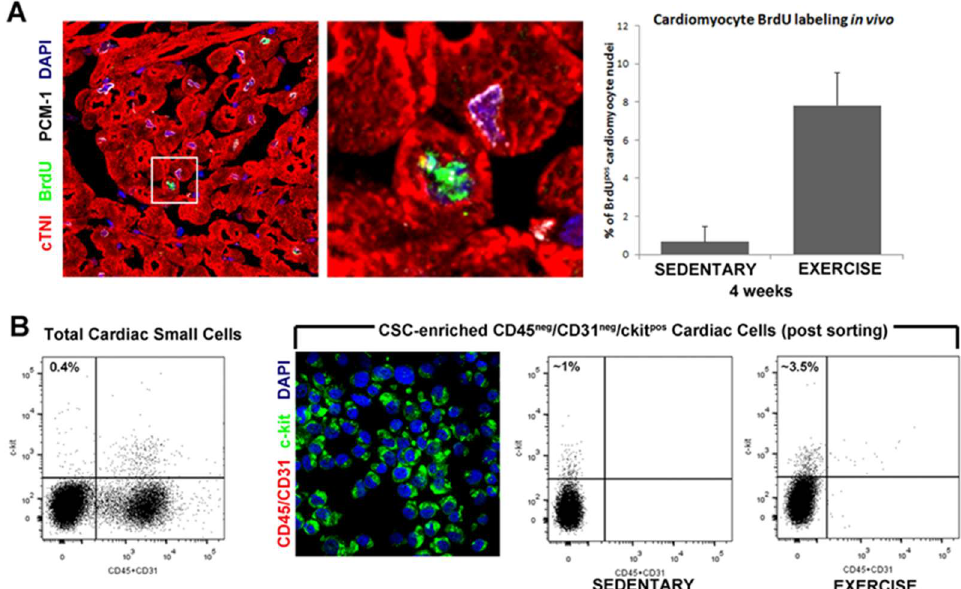
Figure 1. Endogenous cardiac stem cells and new cardiomyocytes formation. ( A ) Representative confocal image and bar graph show an increased number of small, newly formed BrdU pos (green) cardiomyocytes (red, cTnI; white, PCM-1) following 4 weeks of exercise training. DAPI stain the nuclei in blue. ( B ) FACS analysis and immunocytospin of CD45 neg /CD31 neg c- kit pos (CD45/CD31, red; c-kit, green; DAPI, blue) CSCs isolated from the adult mouse heart showing increased number of CD45 neg /CD31 neg c-kit pos CSCs isolated from exercise training animals compared with sedentary